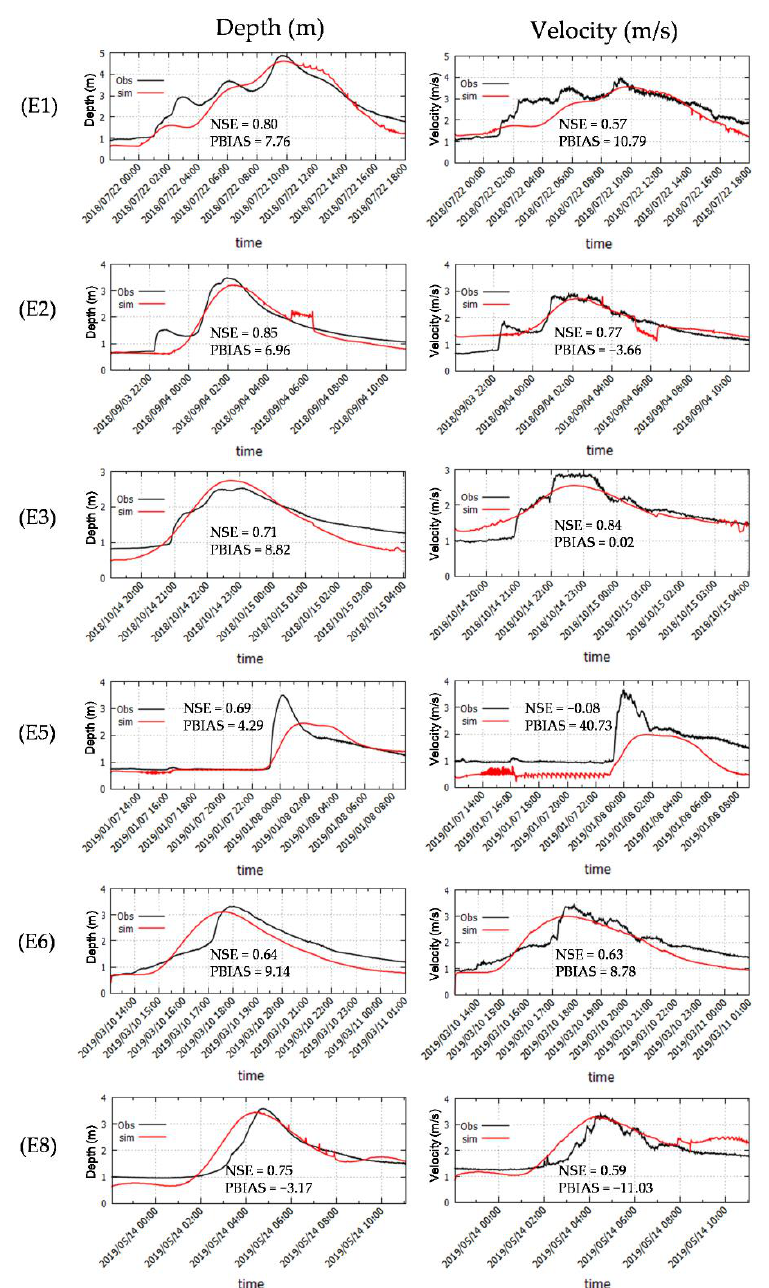
Figure 5. Observed (black line) and simulated (reddish line) water depth (m) and flow velocity (m / s) for the calibration and validation events (E1-E3, E5, E6, E8).